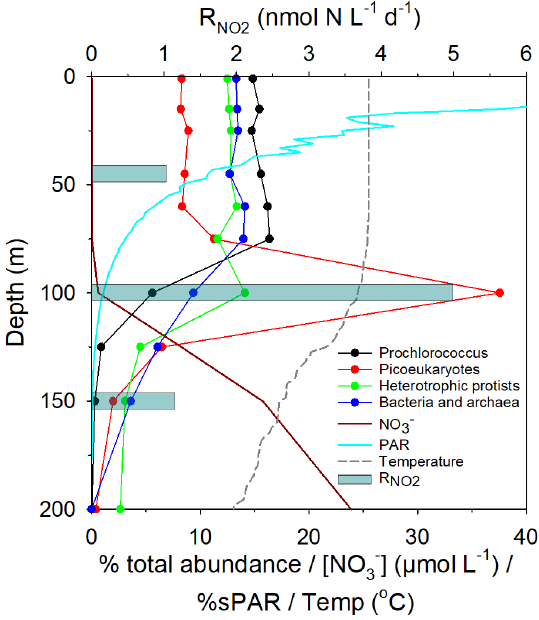
Figure 6. R NO measurements at 7 ◦ S within the context of selected 2 physical, chemical, and biological measurements, illustrating rela- tionships between water column